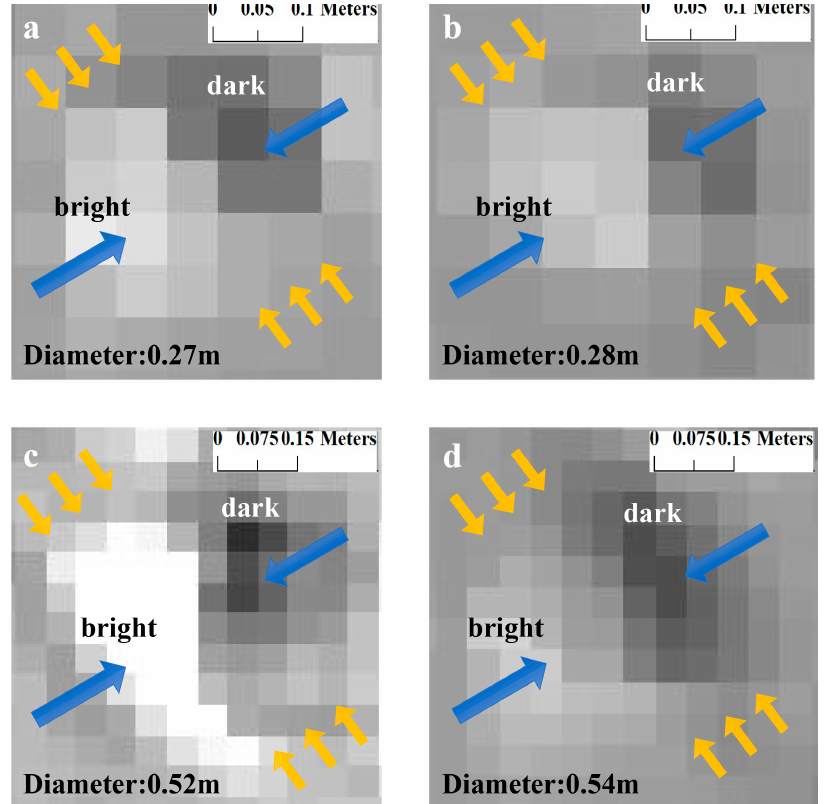
Figure 3. Diagram of impact craters with diameters of 5 pixels ( a , b ) and 10 pixels ( c , d ), with ( c ) a C2 type impact crater and ( d ) a C3 type impact crater. Yellow arrows mark the impact crater boundaries.